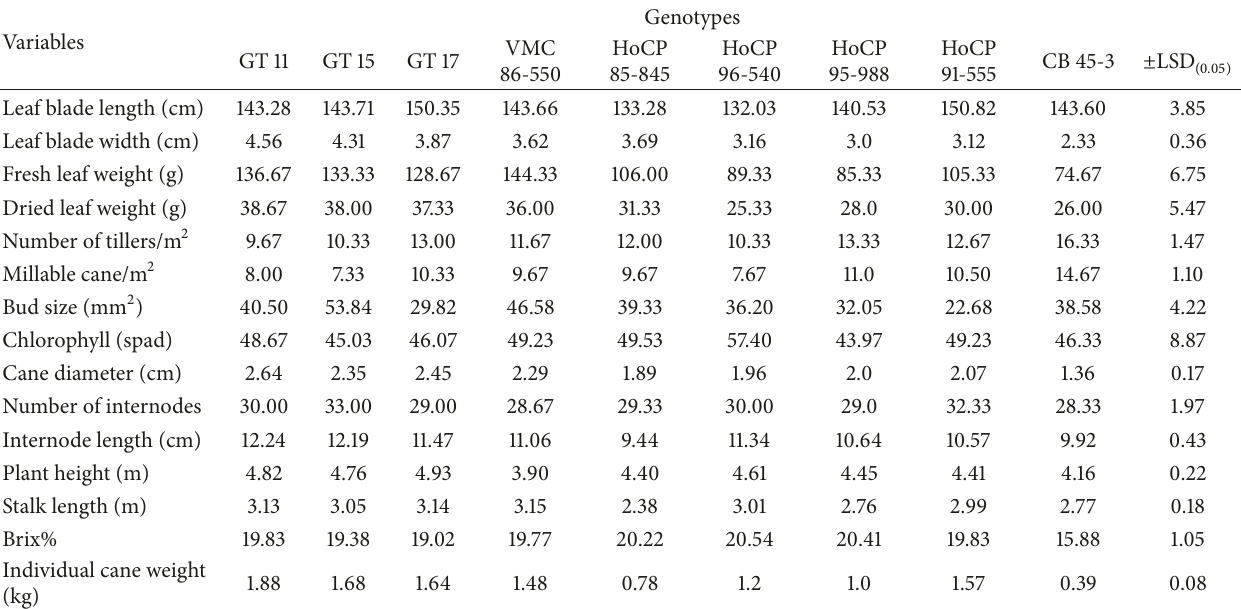
Table 3: Mean performance of the exotic nine genotypes for 15 different